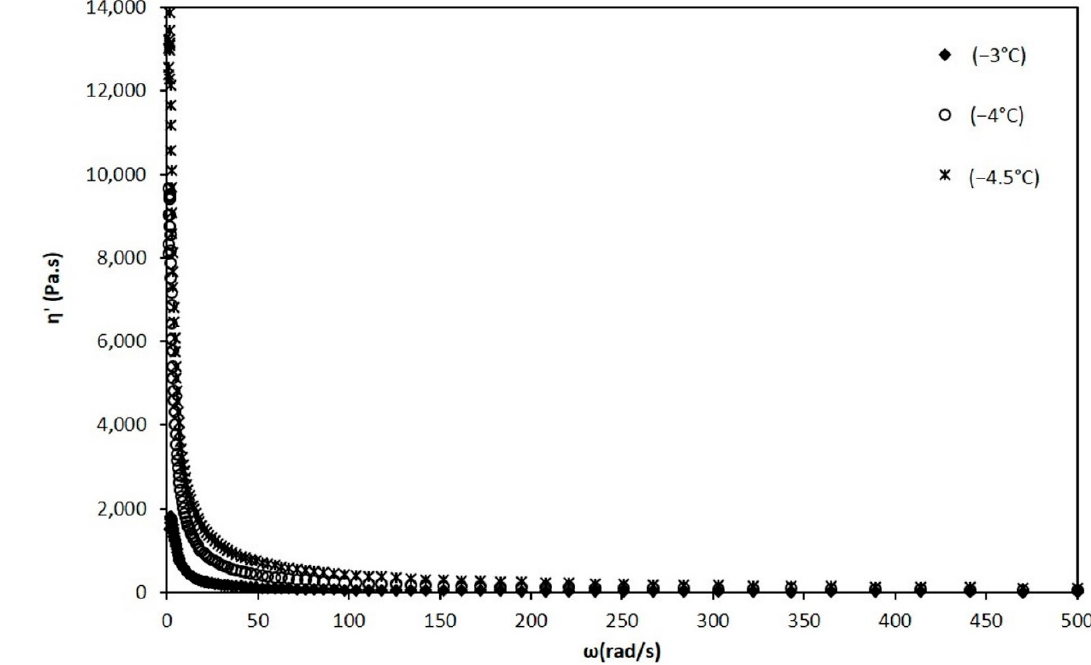
Figure 7. Dynamic viscosity vs. angular frequency at temperatures of − 3, − 4, and − 4.5 °C.